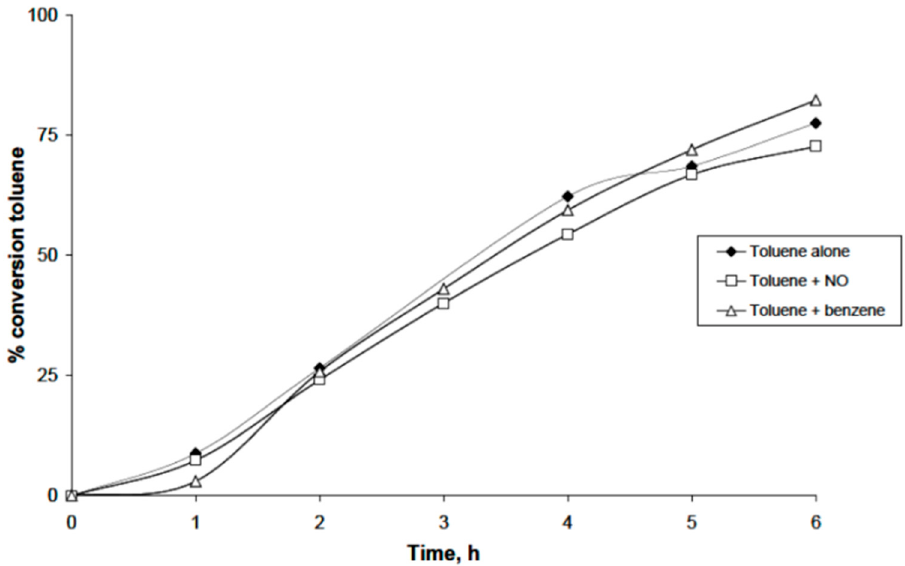
Figure 6. Photocatalytic degradation of toluene alone and in the presence of NO and benzene at RH 60% .